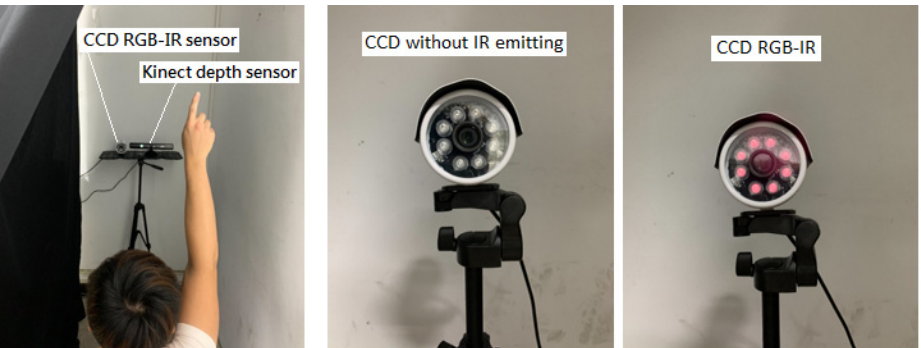
Figure 13. Acquisitions of the hand gesture intention images of different modalities of RGB-IR and depth-grayscale from a CCD camera and a Kinect device. depth-grayscale from a CCD camera and a Kinect